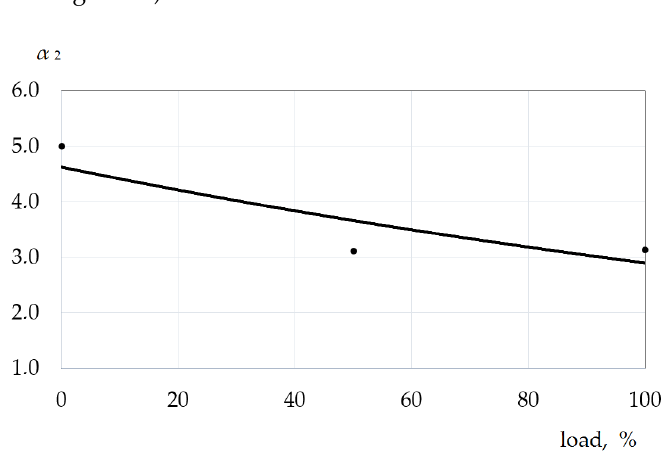
Figure 19. Dependence of surplus secondary air on the load value.